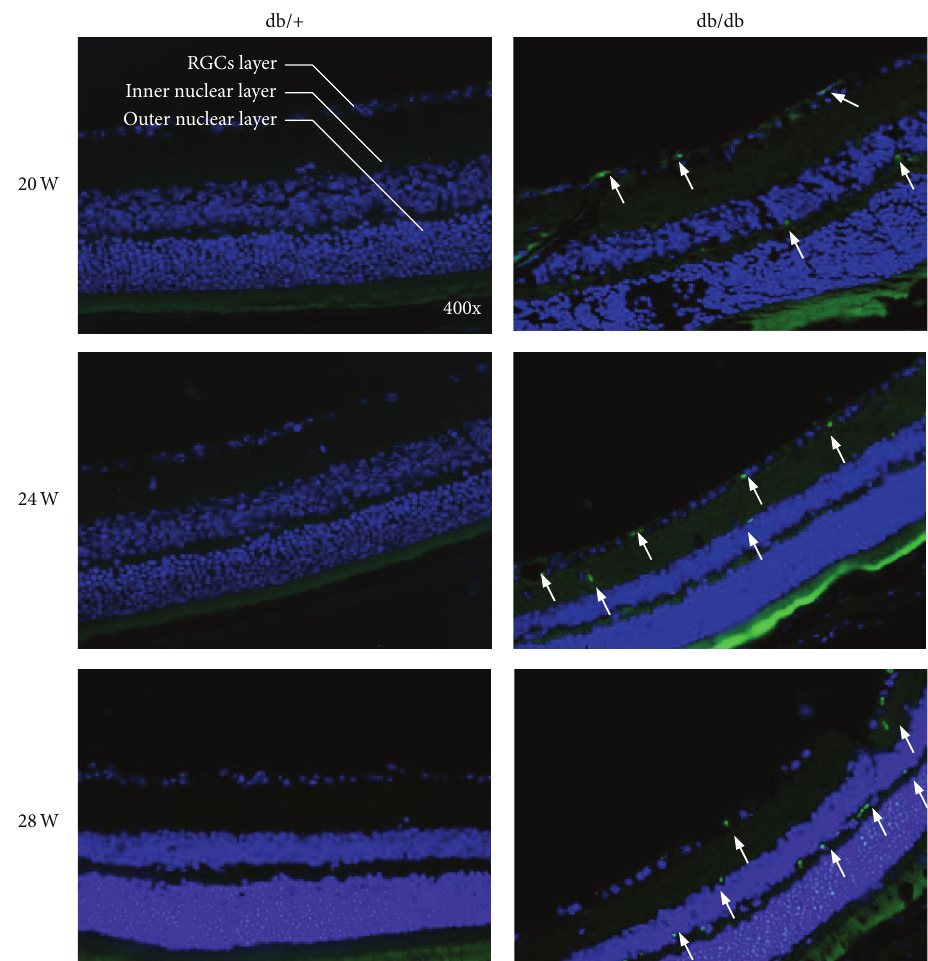
Figure 5: TUNEL assay showed the positive apoptotic RGCs in retina of db/db mice at 20, 24, and 28 weeks of age compared with the controls at 28 weeks. The green fluorescence represented the apoptotic cells in RGCs layer and the inner nuclear layer which were noted by the